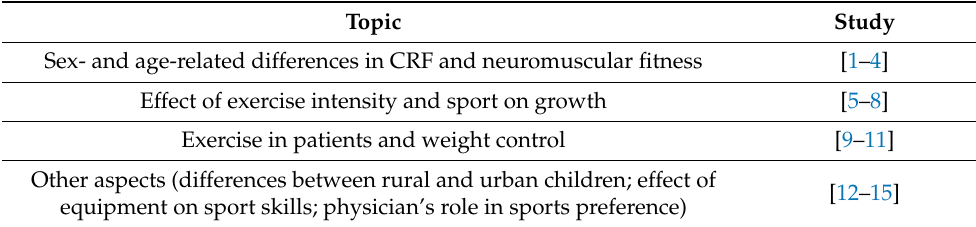
Table 1. Topics of children’s sports physiology in the first studies (English literature) carried out before 1970. Topic Study Sex- and age-related differences in CRF and neuromuscular